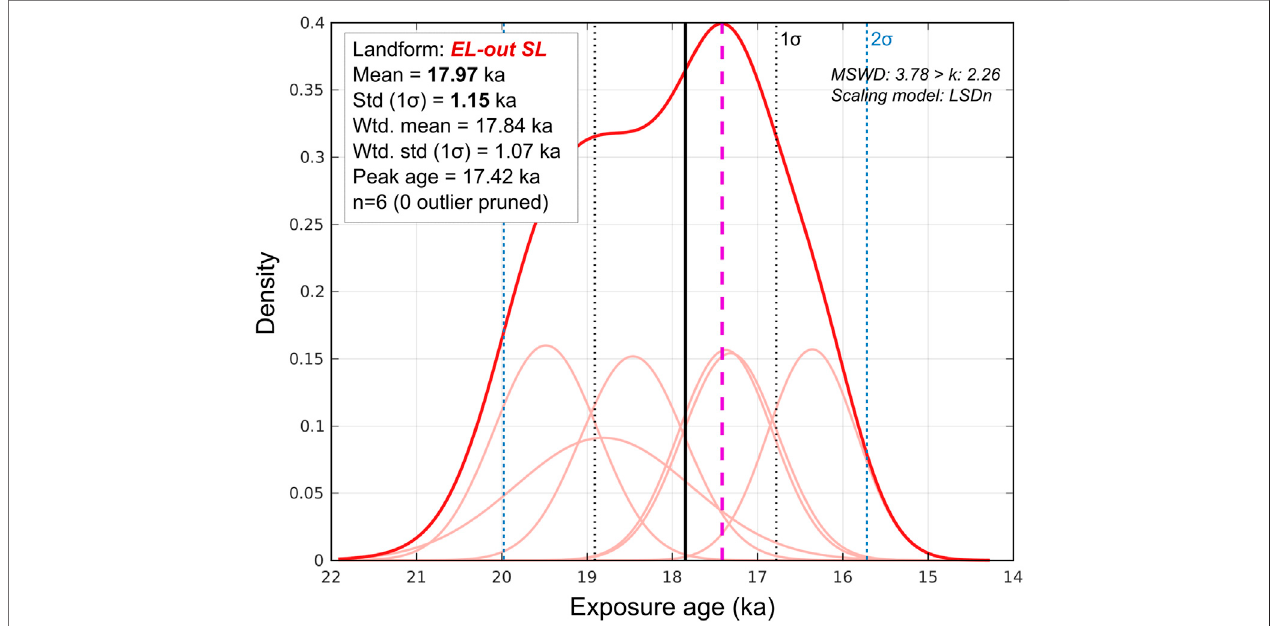
FIGURE 5 | Kernel density plot, adapted from plots produced using the iceTEA tools for exposure dating (Jones et al., 2019a; http://ice-tea.org/en/) and TCN datingsummarystatistics forthe EL-outsouthern lateral(EL-outSL)moraine bouldersamples(n (cid:1) 6). Thick red curve represents thesummedprobabilitydistribution for the age population while thin red curves depict Gaussian curves for individual samples. Vertical black lines denote the arithmetic mean, while thin black and blue vertical dashed linesdenotethe1 σ and2 σ con fi denceintervalsofthemean,respectively.Thickpurpleanddashedverticallinehighlightsthepeakageassociatedwiththe summed probability distribution. Std : standard deviation, Wtd. mean : uncertainty-weighted mean, Wtd. std : uncertainty-weighted standard deviation.